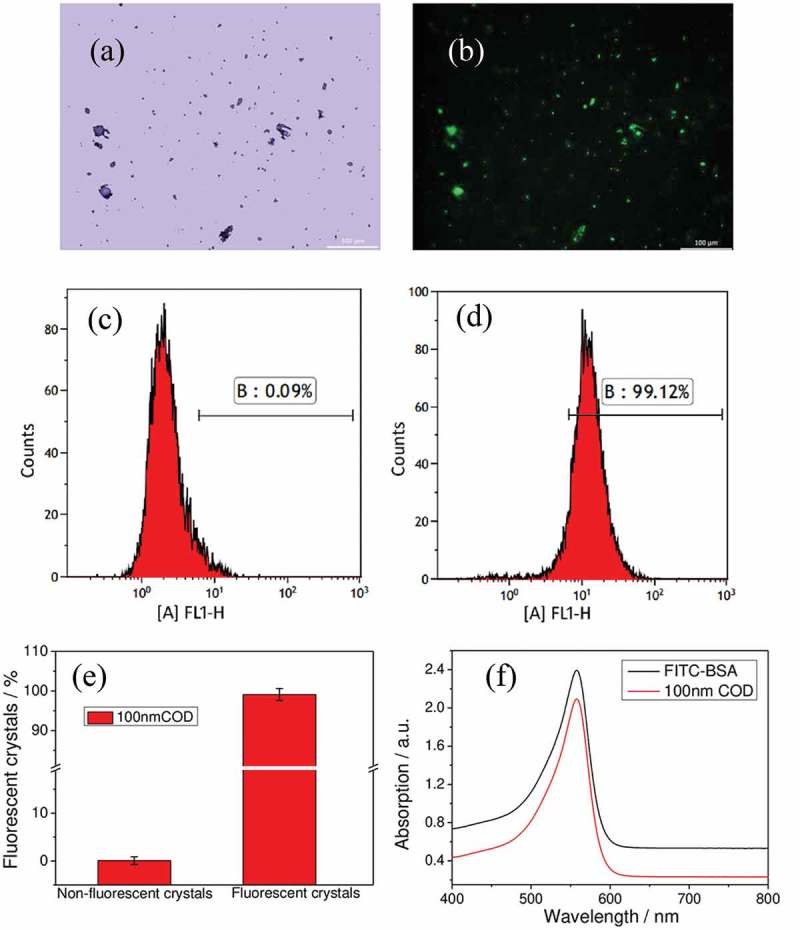
FITC-IgG fluorescent labeling of nano-COD crystals. (a, b) COD crystal images before and after labeling; (c, d) flow cytometric analysis histogram of fluorescent ratio of plain and FITC-IgG fluorescent-labeled nano-COD crystal; (e) fluorescent COD crystal percentage statistics histogram; (f) UV-visible absorption spectra of FITC-IgG and its labeled COD solution.